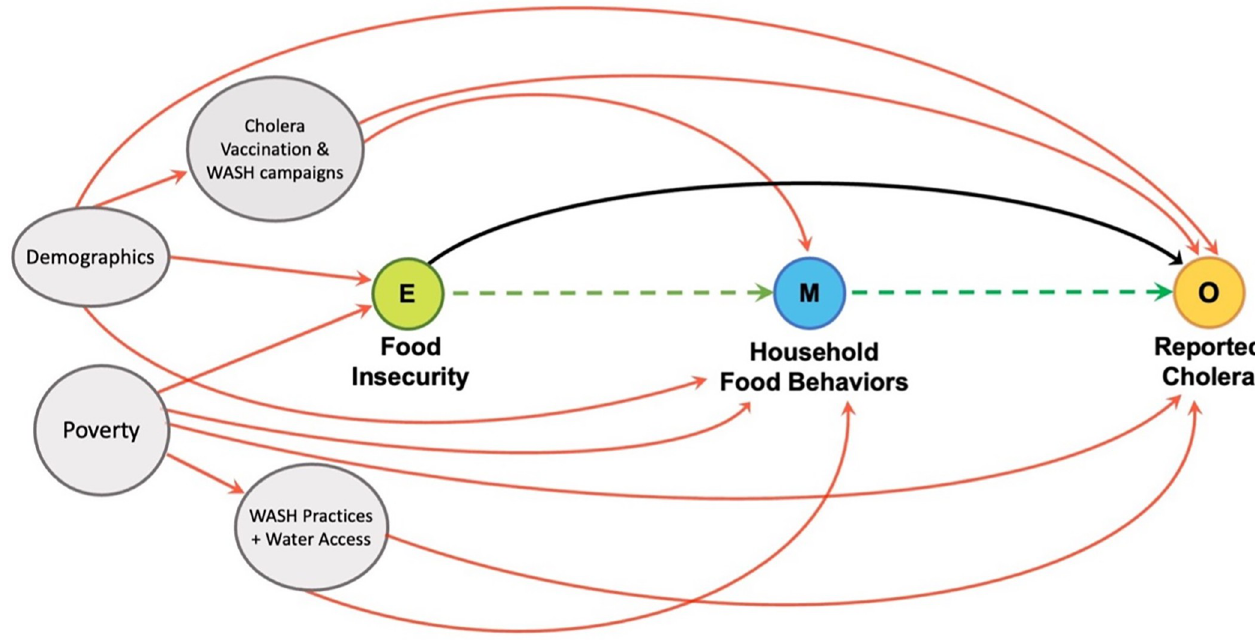
Fig 1. Directed acyclic graph illustrating hypothesized relationship pathways. Exposure is shown in green, mediating food behaviors in light blue, confounders in grey, and outcome in yellow. The indirect effect of food insecurity occurring through mediating household food behaviors is shown in green (dashed line). The direct effect of food insecurity on cholera is shown in black, and that of confounders in red.